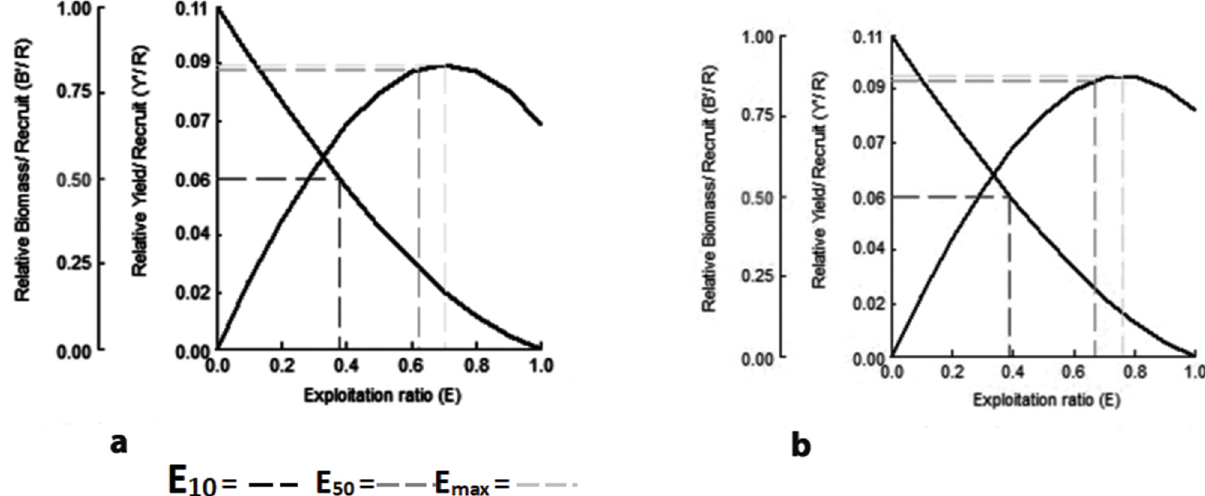
Fig. 9. Beverton and Holt yield/recruit for (a) female and (b) male P. stylifera .